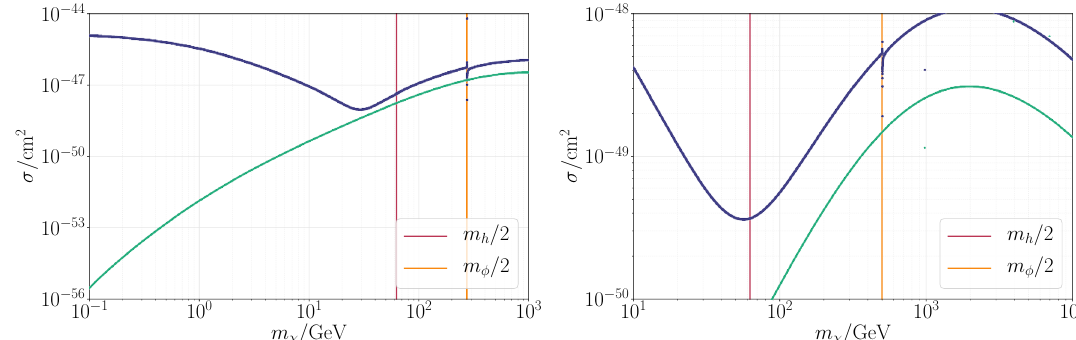
Figure 12 . In both figures the SI cross section is shown as a function of the DM mass m χ . The green line indicates the result calculated in our presented approach and the blue line corresponds to the approach including the additional gluon contributions discussed in section 4.2.6. In the left plot, our starting point is the benchmark given in table 1 and on the right side the result using as starting point the benchmark presented in [10] with m φ = 1 TeV , v s = 2 v and sin α = 0 . 2 is shown.